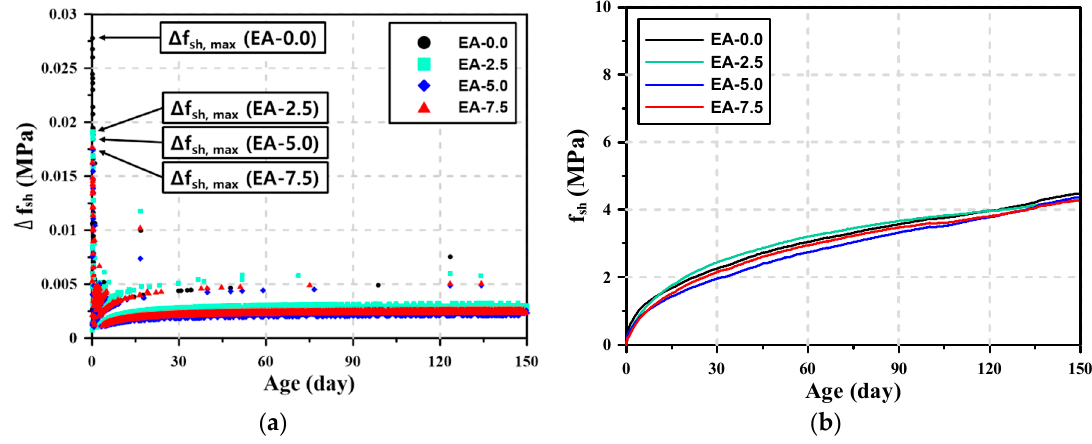
Figure 5. Stress generated by shrinkage. ( a ) Stress generated per unit time ( Δ f sh ), and ( b ) shrinkage stress ( f sh ). Table 7. Shrinkage stress by age according to expansive additive content.